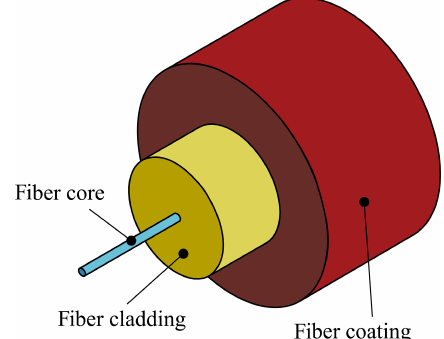
Figure 1. Slip relationship between the matrix and the fiber core based on Cheng et al. (2005).